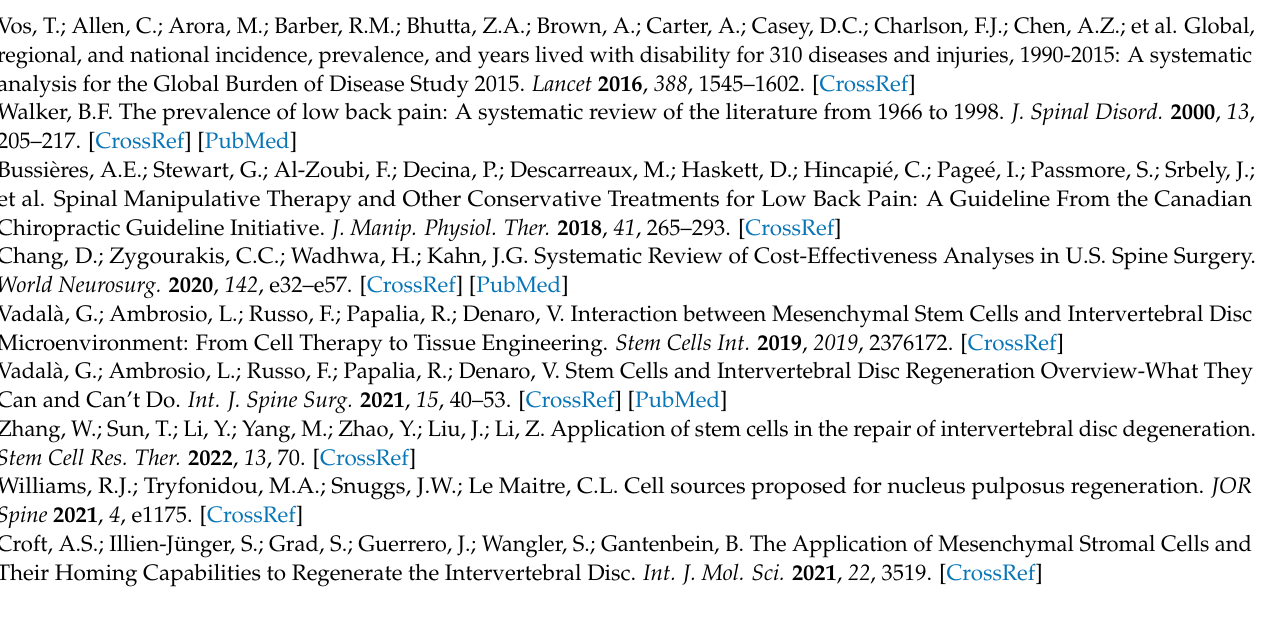
experimental design; Figure S2: qPCR sample setup; Figure S3: Metabolic activity of hMSC pellets and the cell loss and proliferation in untreated and o-Vanillin-treated pellets in the start and end of the 21-day culture. Related to Figure 1; Figure S4: EVs in complete cell culture media and from unlabeled hMSCs and DCs in the respective CM. Related to Figure 3; Figure S5: Unlabeled and labeled DC and hMSC control samples. Related to Figure 4. References [17,55] are cited in the Supplementary